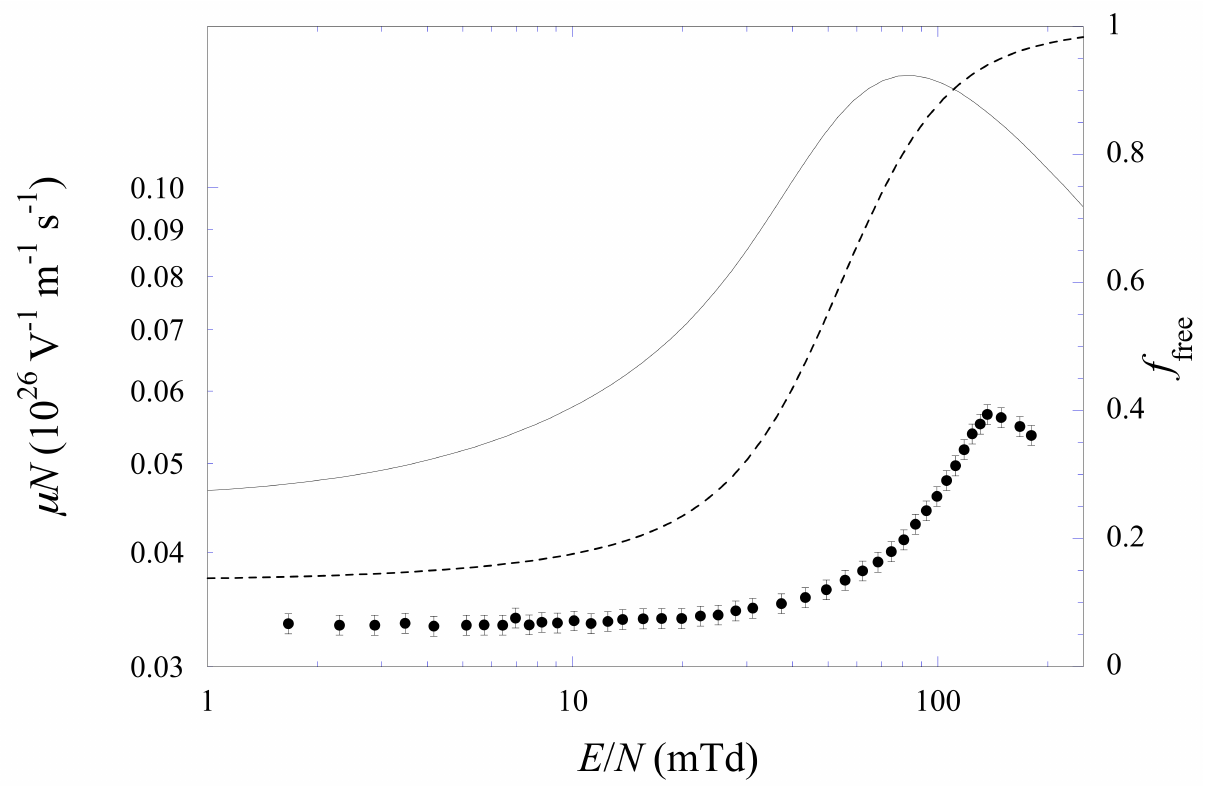
10 26 m − 3 (closed points) and prediction of the heuristic ×